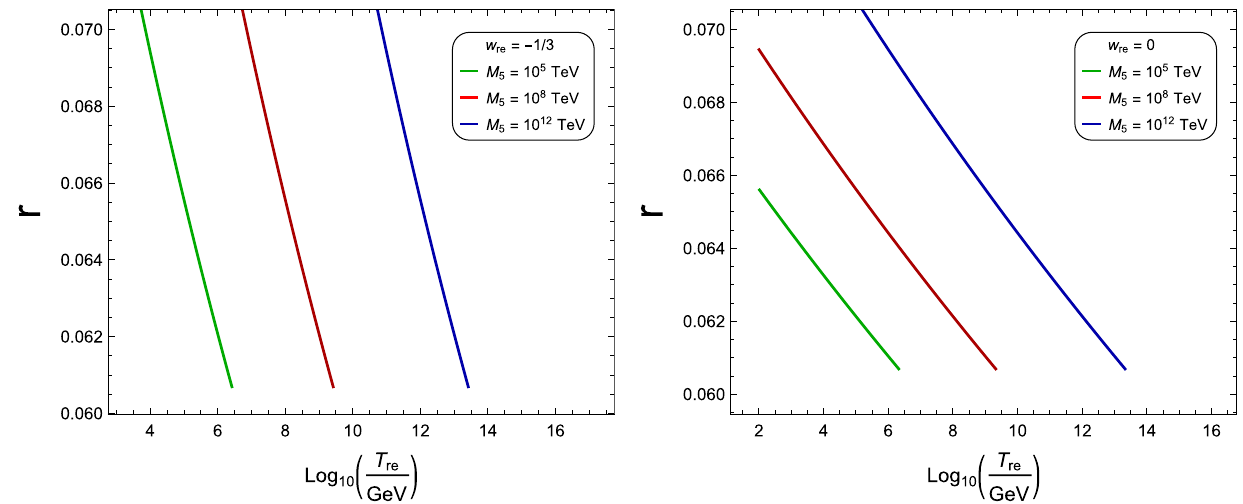
Fig. 14 Plots for the tensor-to-scalar ratio against the reheating temperature for Exponential SUSY inflation for w re = − 1 / 3 , 0 and α = 0 . 0185. The green, red and blue lines corresponds to a mass of M 5 = 10 5 TeV, M 5 = 10 8 TeV and M 5 = 10 12 TeV